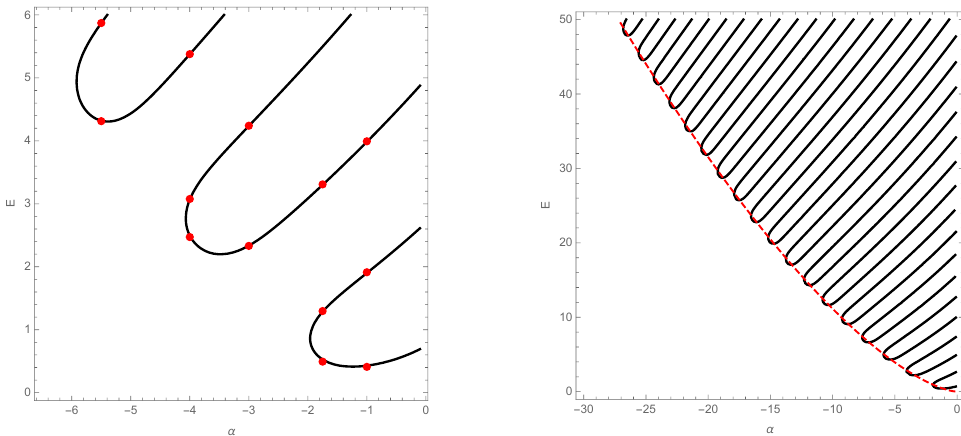
Figure 2 . (Left) The curves in the ( (cid:11); E ) plane de(cid:12)ned by the approximate quantization condi- tion (3.9), for ~ = 1. The red dots are numerical values for the spectrum of (1.2) obtained with complex dilatation. (Right) There are clearly two di(cid:11)erent phases in the ( (cid:11); E ) plane separated by the line (3.10), which is shown here in dashed